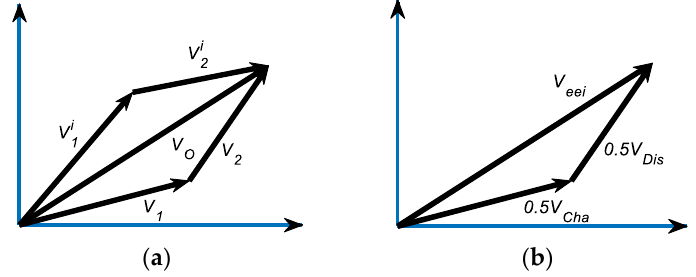
Figure 1. Vector analysis of steady-state AC fundamental voltage responses: ( a ) there are infinite sets of two vectors ( V 1i and V 2i ) equivalent to target vector ( V O ) in rotating coordinate; ( b ) the target vector ( V eei ) is equivalent to the sum of new charging (0.5 V Cha ) and discharging (0.5 V Dis ) vectors by linear superposition.